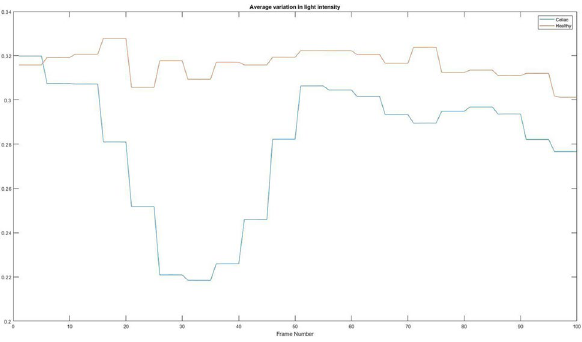
Figure 12. Average variation in light intensity. Red = Healthy and Blue = Celiac.